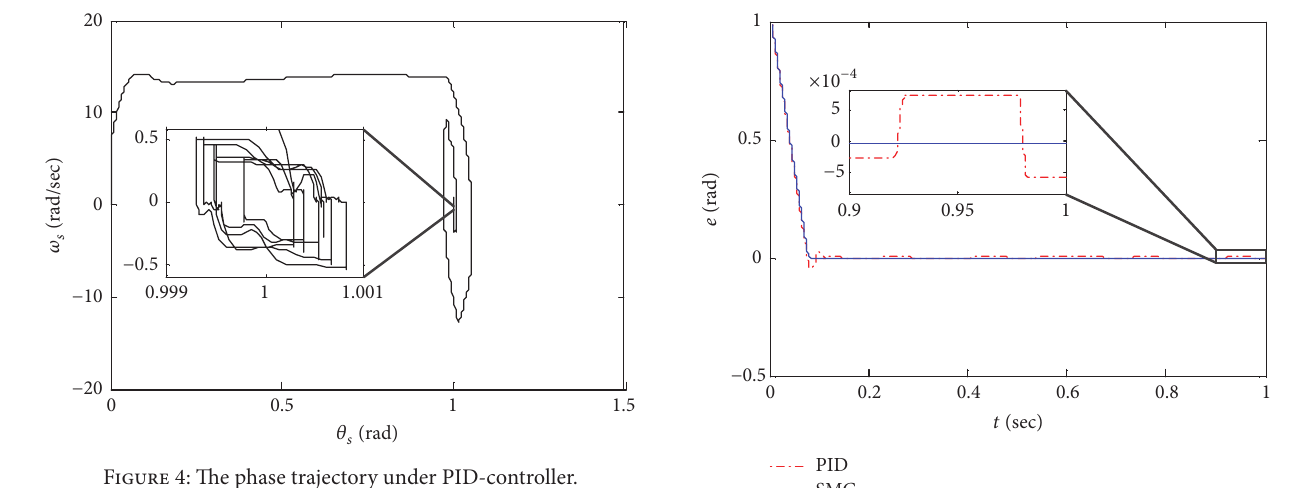
Figure 4: The phase trajectory under PID-controller.